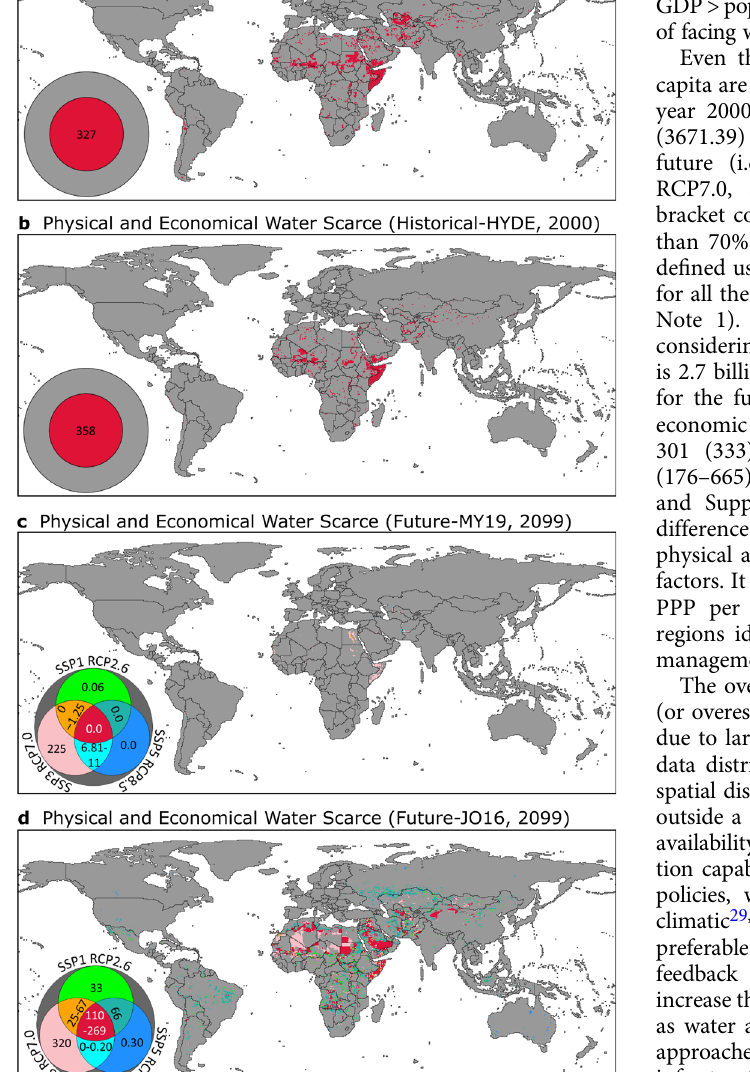
Fig. 3 Physical and economic water-scarce regions. a Historical (2000) considering the GPWv4 dataset, ( b ) Historical (2000) considering the HYDE3.2 population dataset, ( c ) Future (2099) considering the MY19 population dataset, and ( d ) Future (2099) considering the JO16 population dataset scenarios. The future (2099) case shows the possible combinations of scenarios with different colours; the values inside the circular legend show the number of people (in millions) facing scarcity with ranges representing the minimum and maximum values considering scenarios million (range shows the minimum and maximum population affected considering all three future scenarios), considering the historically available freshwater for future scenarios, i.e., Historical- MY (Historical-JO) experiments. Similarly, the population affected